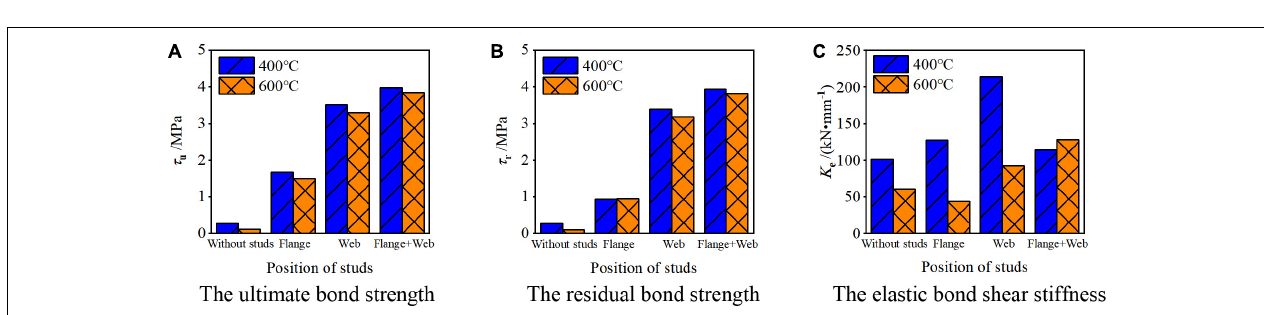
FIGURE 8 | Effect of RP. (A) The ultimate bond strength. (B) The residual bond strength. (C) The elastic bond shear stiffness.